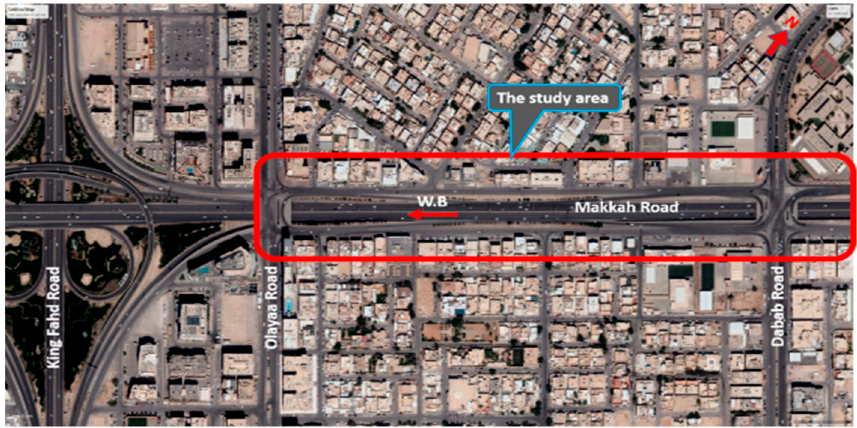
Figure 1. Aerial photo of the study area.